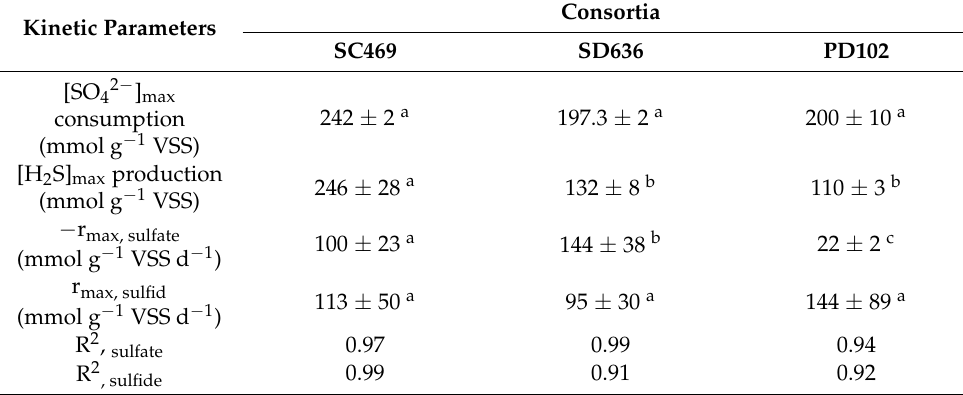
Table 3. Kinetic parameters using SC469, SD636 and PD102 consortia determined in microcosm experiments: [SO 42 − ] max maximum specific sulfate consumption, [H 2 S] max maximum specific hydro- gen sulfide production, r max , sulfate maximum specific sulfate consumption rate and r max , sulfide maximum specific hydrogen sulfide production